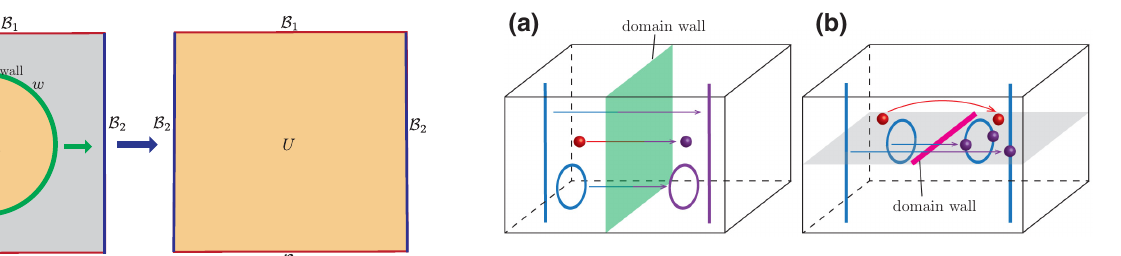
FIG. 24. An illustration of the correspondence between a transversal logical gate (or a local constant-depth circuit) U and domain-wall sweeping in 2D. The application of U R in a region R is equivalent to sweeping the corresponding gapped domain wall w to the boundary of the region R . When passing through the codimension-1 domain wall w across the entire system, the domain wall condenses on the external boundaries B i and one effectively applies the global symmetry U to the entire system corresponding to the transversal logical gate (or constant-depth circuit). The external boundaries B i are required to be invariant under the action of U according to Eq. (47).